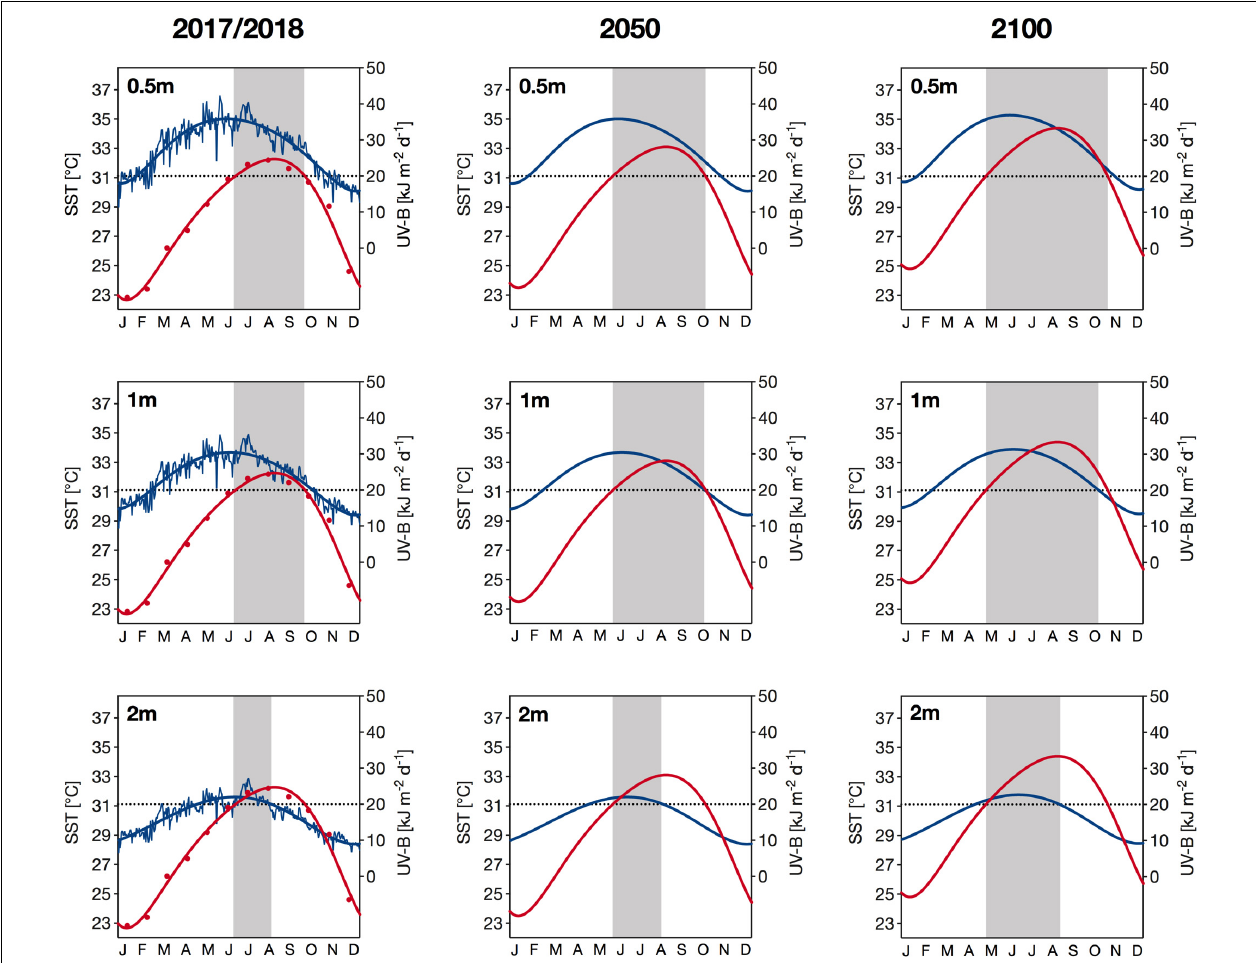
FIGURE 7 | Current (years 2017/2018; left column ) and projected (year 2050: middle column ; year 2100: right column ) sea surface temperatures (SST; in red) and daily UV-B exposure (280–315 nm) (in blue) at Al Fahal reef in 0.5m (top row) , 1 m (middle row) and 2 m depth (bottom row) . Current UV-B exposure are the daily means of exposure received in 2017 and 2018, while current temperature is shown as the monthly mean temperature during the same period. Thick lines represent sixth-order polynomial trendlines. Projected SST values were calculated based on an annual warming rate of 0.026 ◦ C, which is the mean of the two warming rates reported for the central Red Sea by Chaidez et al. (2017) and Osman et al. (2018). Daily UV-B exposure in 2050 are identical to current exposure, while exposure in 2100 are 3% higher, representing the projected increase of UV-B radiation in the tropics according to the latest future-UV radiation models (Bais et al., 2019; Meul et al., 2016). The dotted black line indicates (1) the threshold of severely damaging UV-B exposure (i.e., > 20 kJ m - 2 d - 1 ) for corals (Zhou et al., 2016) and (2) the climatological maximum monthly mean (31.1 ◦ C) of the Jeddah region (Osman et al., 2018). Shaded areas indicate periods when both parameters exceed the aforementioned